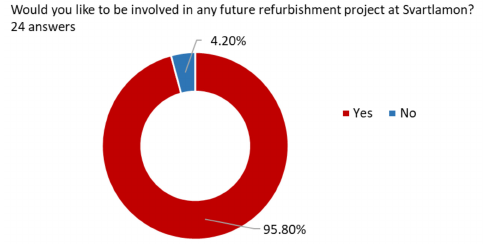
Figure 19. Participants interest in involvement in future renovation plans.